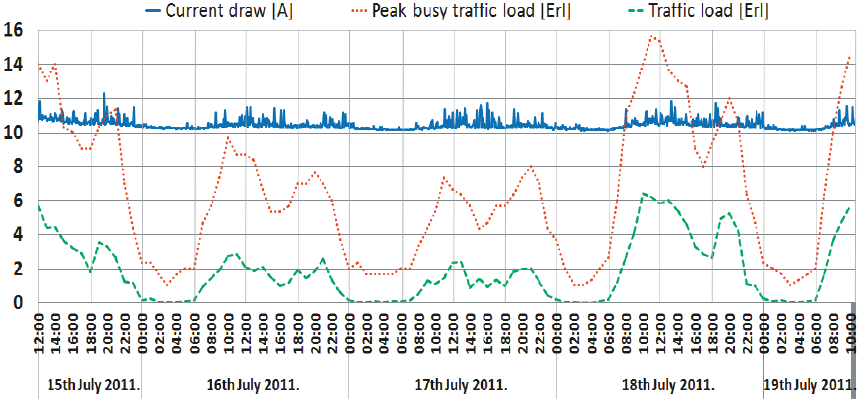
Figure 10. Comparison between electric current draw and traffic load for UMTS